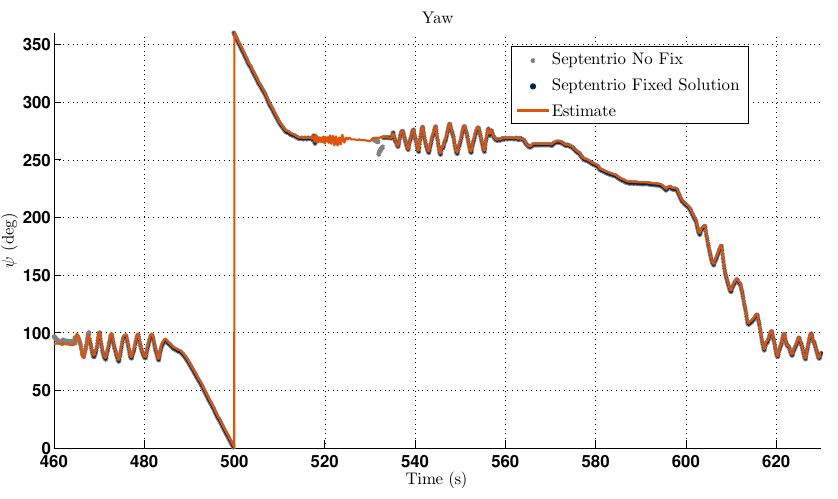
Figure 10. Yaw comparison on the NCAT oval track 15-state cascaded EKF.